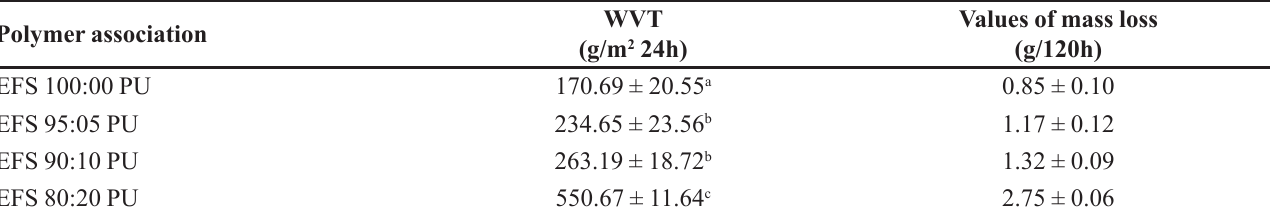
TABLE I - Values of mass loss and water vapor transmission (n=3). Means in a column with different superscripts (a - c) are significantly different ( p <0.05, by Tukey’s